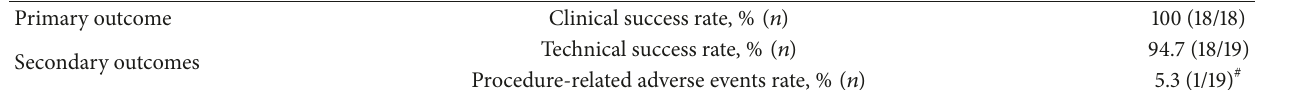
Table 2: Outcomes of endoscopic transpapillary gallbladder stenting (𝑛 = 19) .